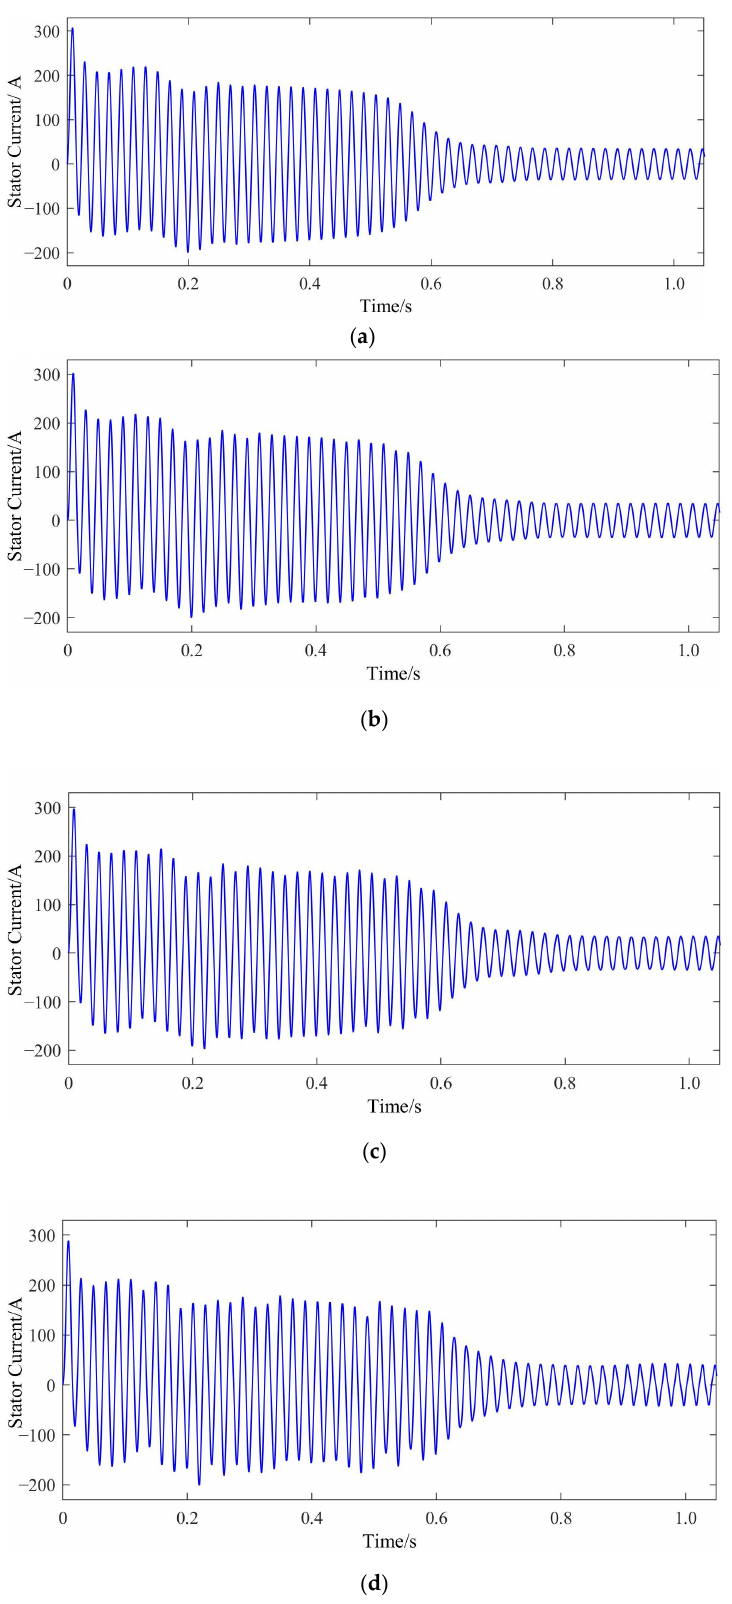
Figure 3. Current waveforms at different fault levels : ( a ) normal; ( b ) one broken bar; ( c ) Two broken